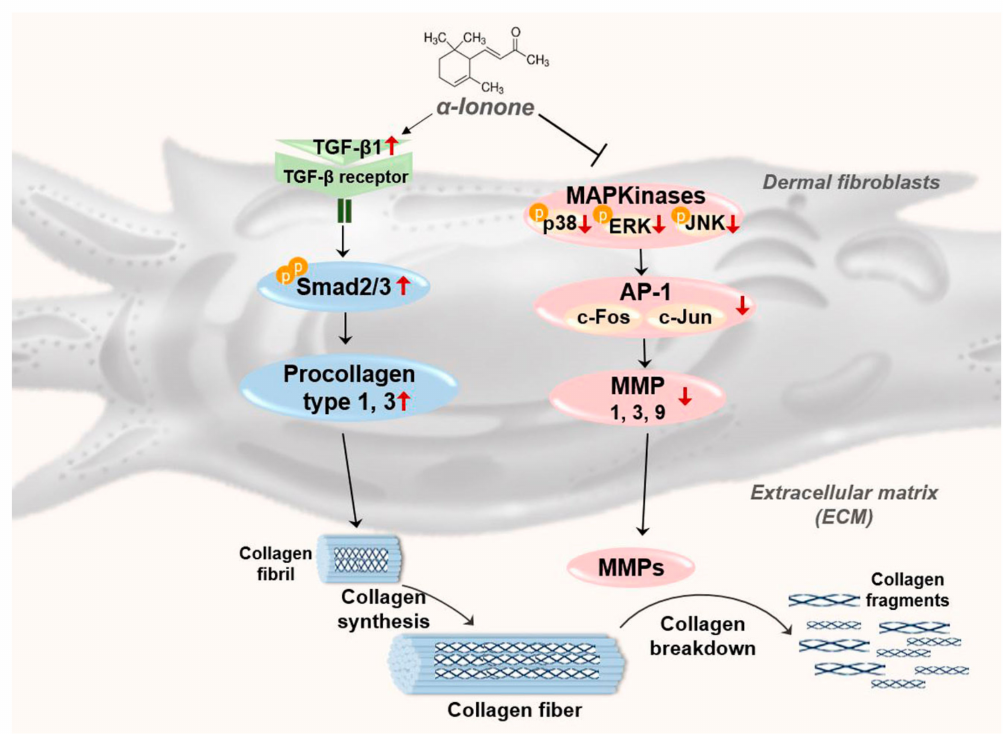
Figure 6. A schematic diagram illustrating the proposed mechanism by which α -ionone improves photoaging in dermal